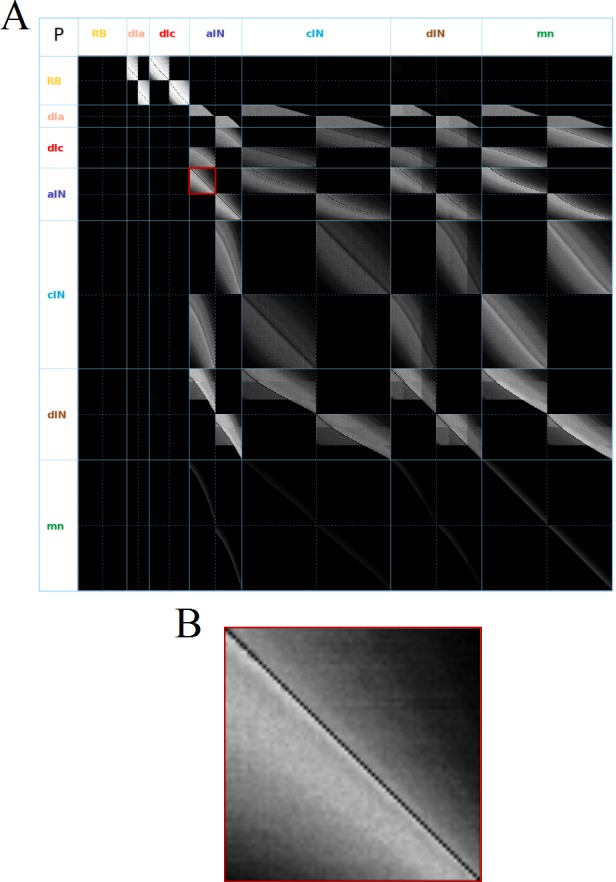
Visualization of the probability matrix P.(A) Image representation of the complete matrix P, where the greyscale intensity of the pixel in row i and column j represents the value of the probability pij. Black intensity corresponds to connection probability zero and grey intensity close to white corresponds to connection probability one. Rows and columns corresponding to neurons of each of the seven types are separated by solid blue lines. These lines separate the matrix into symmetrical sub-blocks. Within each sub-block vertical and horizontal dotted lines separate the left body side (top rows and left columns) from the right body side (bottom rows and right columns). In each sub-block neurons are ordered according to increasing rostro-caudal position B. Zoom of the left body side aIN→aIN sub-block (marked by a red square in A).